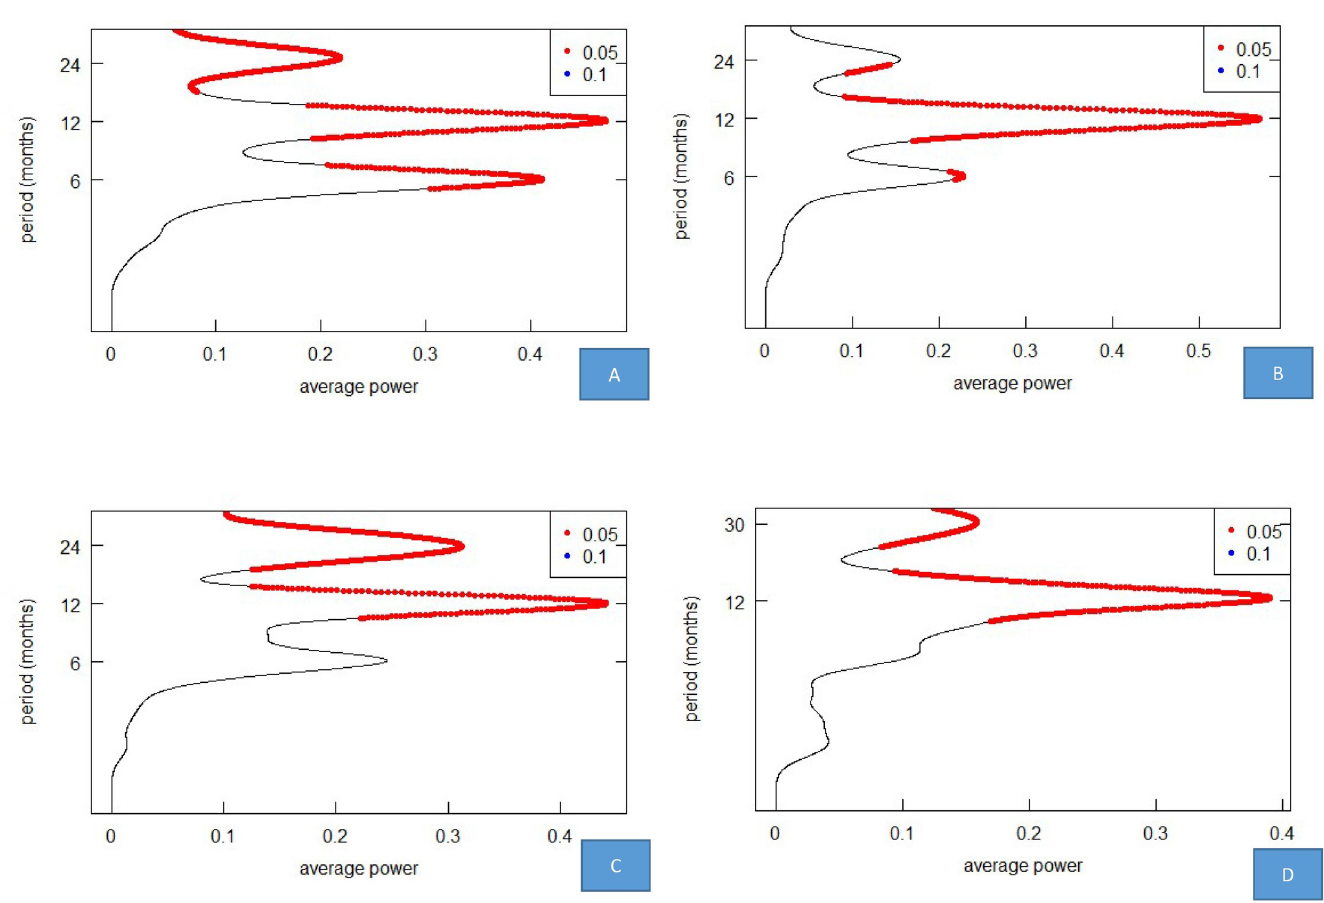
Fig 4. The average power of HFMD for the total case, EV71 case, Cox A16 case and Other enteroviruses cases. (A) Wavelet spectrum of the total case. (B) Wavelet spectrum of the EV71 case. (C) Wavelet spectrum of Cox A16 case. (D) Wavelet spectrum of other